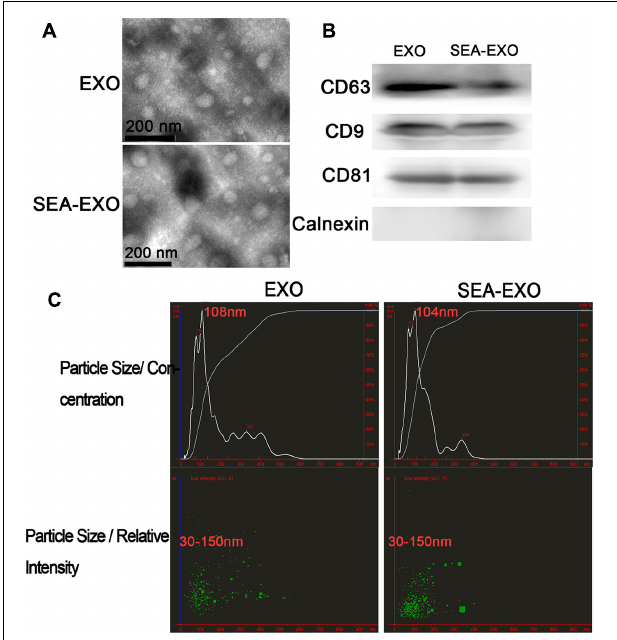
FIGURE 1 | Successful isolation of exosomes from the supernatant of DCs treated with SEA (SEA-EXO) or untreated (EXO). (A) Exosome ultrastructure was confirmed via negative-staining TEM. (B) The expressions of the exosome-specific markers CD63, CD9, and CD81 were confirmed via western blotting. (C) The size distribution profile of the exosomes was investigated using